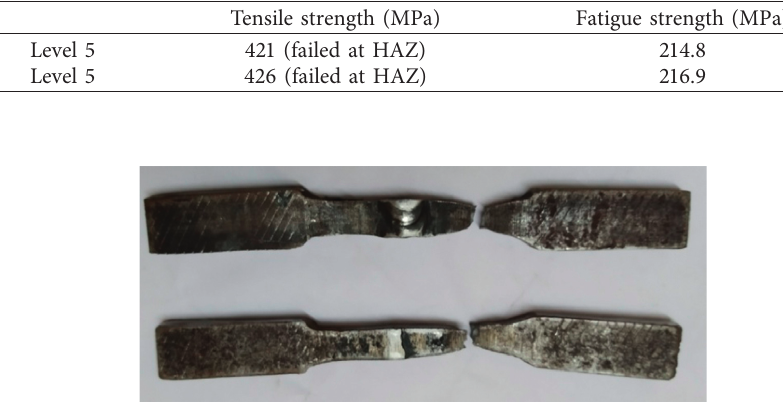
Figure 14: Failure of tensile